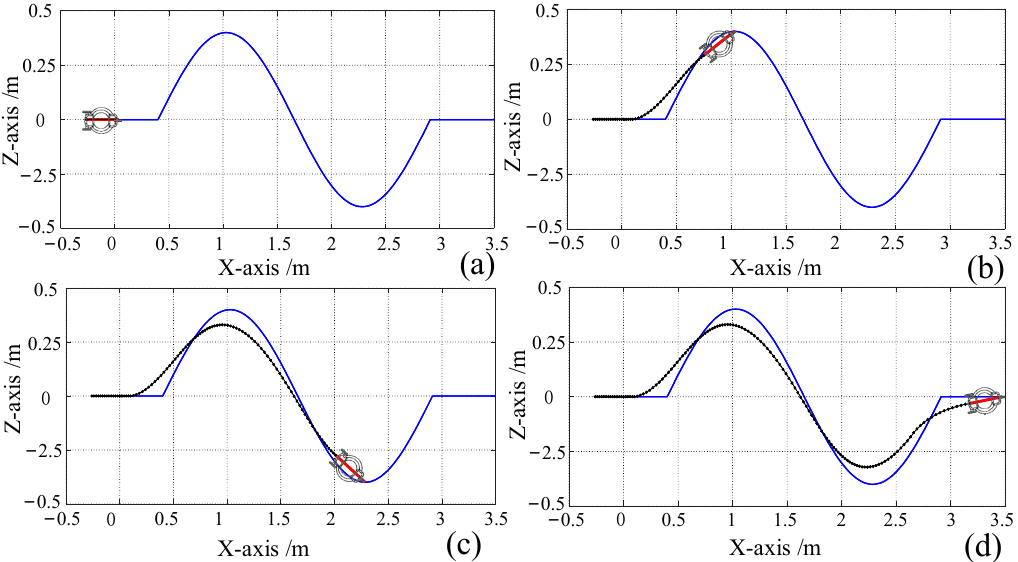
Figure 5. The timing diagram for WMR trajectory tracking; ( a – d ) show the position of the WMR at 0, 33, 66, and 100% of the tracking path, respectively.